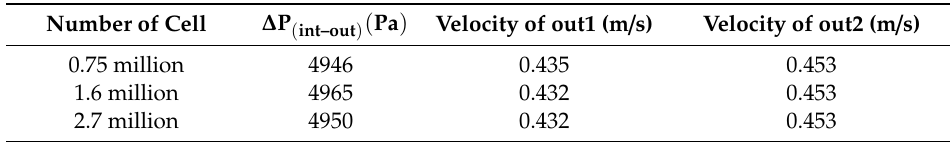
Table 3. Influence of number of grid cells.